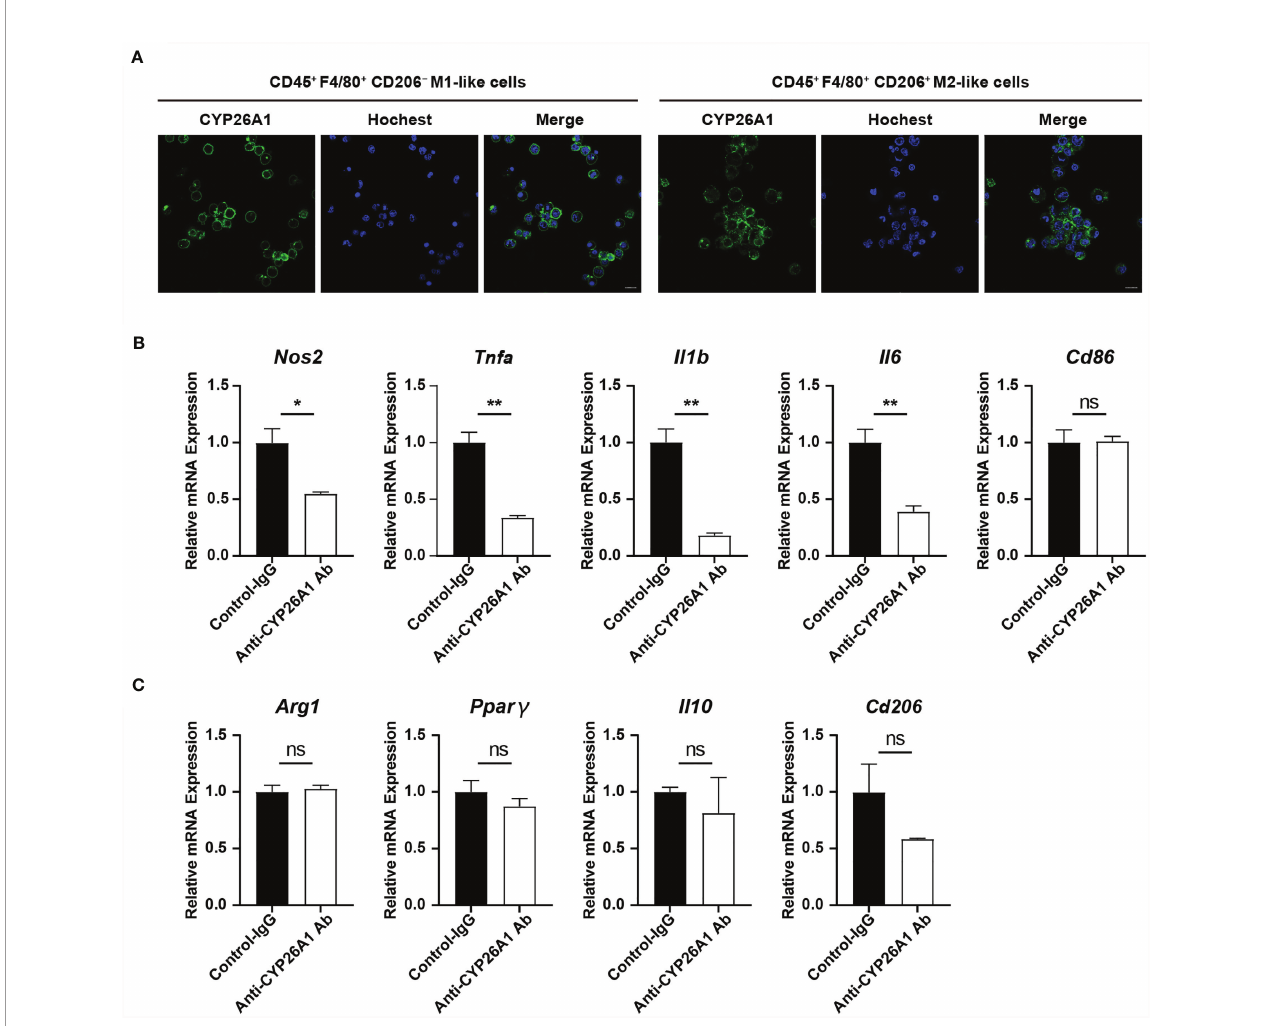
FIGURE 4 | The effect of inhibiting the activity of CYP26A1 on the polarization level of uterine macrophages. (A) Live cells immuno fl uorescence analysis CYP26A1 expression in M1-like and M2-like macrophages isolated from the uterus on GD6 mice. Scale bar, 10 µm. (B) qPCR analysis of M1 markers ( Nos2 , Tnfa , Il1b and Il6 ) on uterine macrophages treated with anti-CYP26A1 Ab or control IgG for 12 h and then induced with LPS and IFN- g for 4 h (n=3). (C) qPCR analysis of M2 markers ( Arg1 , Pparg , Il10 and Cd206 ) on uterine macrophages treated with anti-CYP26A1 Ab or control IgG for 12 h and then induced with IL-4 and IL-13 for 4 h (n=3). Error bars represent means ± SEM; two-tailed unpaired t-test, ns, not signi fi cant, *P < 0.05 or **P <